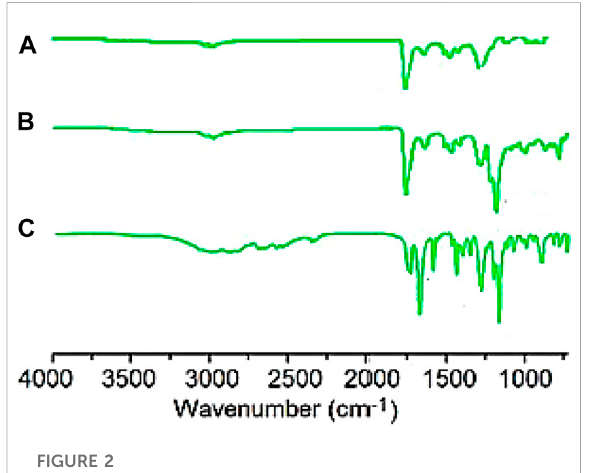
FIGURE 3 CHNSO/analysis for Sc-MOF@SiO 2 core/shell nanostructures synthesized using the ultrasonic-assisted microwave